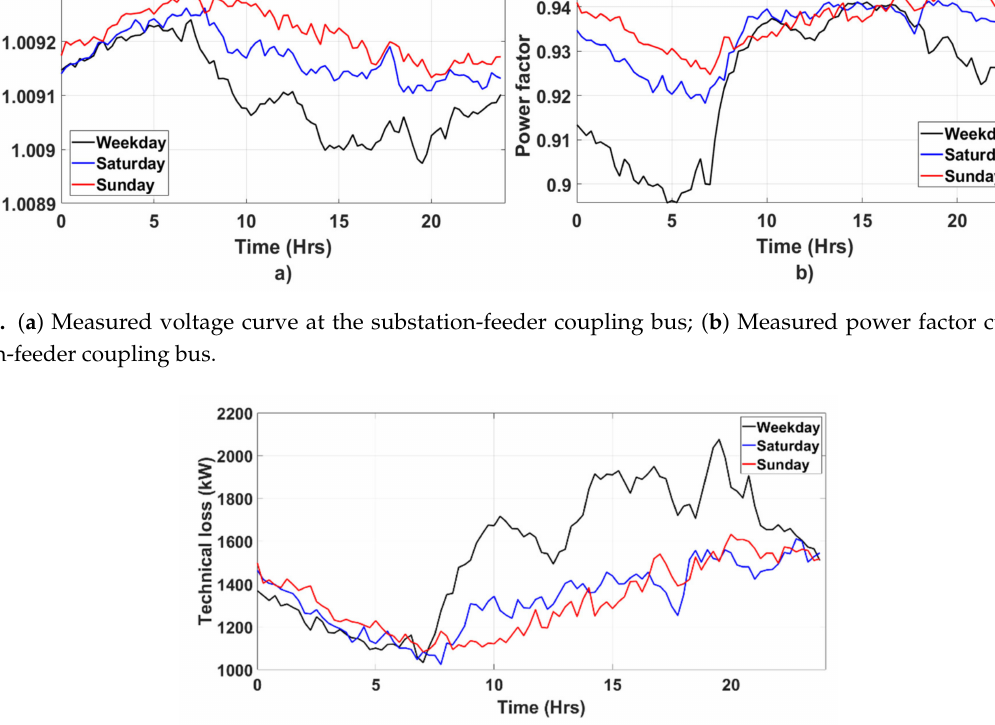
Figure 17. Feeder’s total active technical loss curves, which includes technical losses due to supplying regular and irregular consumers and other sources of non-technical losses.